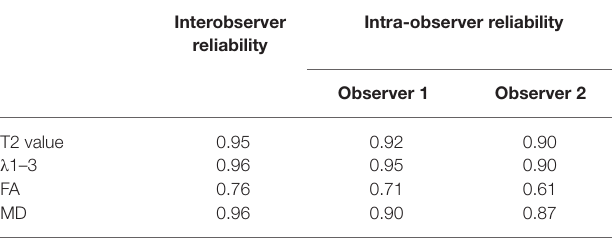
TABLE 3 | Interobserver reliability and intra-observer reliability of T2 value and DTI